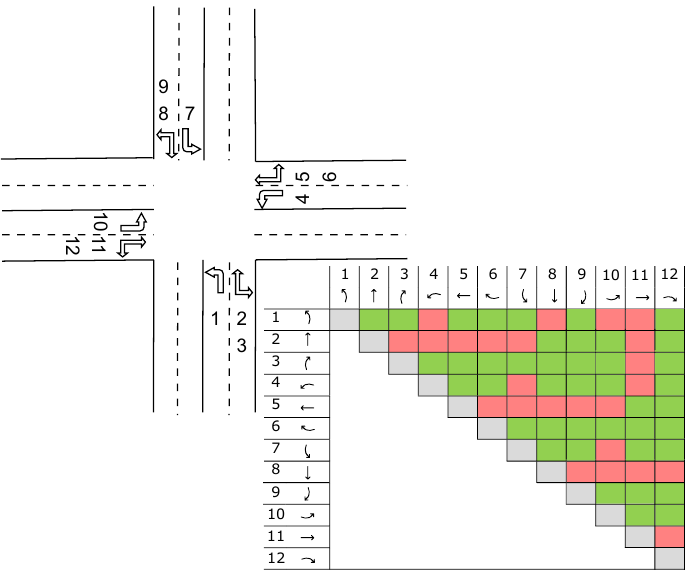
Figure 6. Intersection layout for case study II; non-conflict (green) and conflict (red) sets of